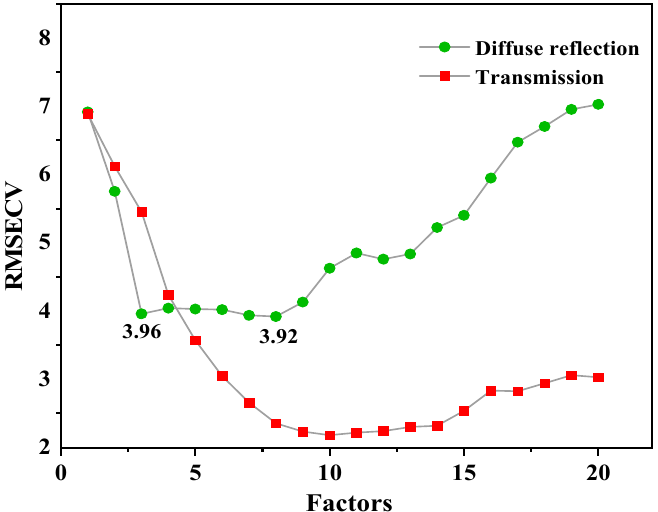
Figure 9. Variation of the factor numbers using different detection methods. Table 3. Descriptive statistics of the PLS models for the calibration and validation sets.